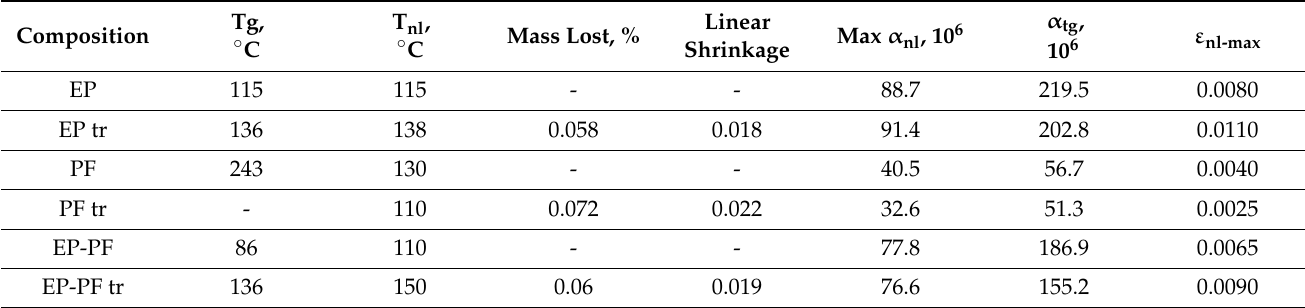
Table 3. Dilatometry of GP results.